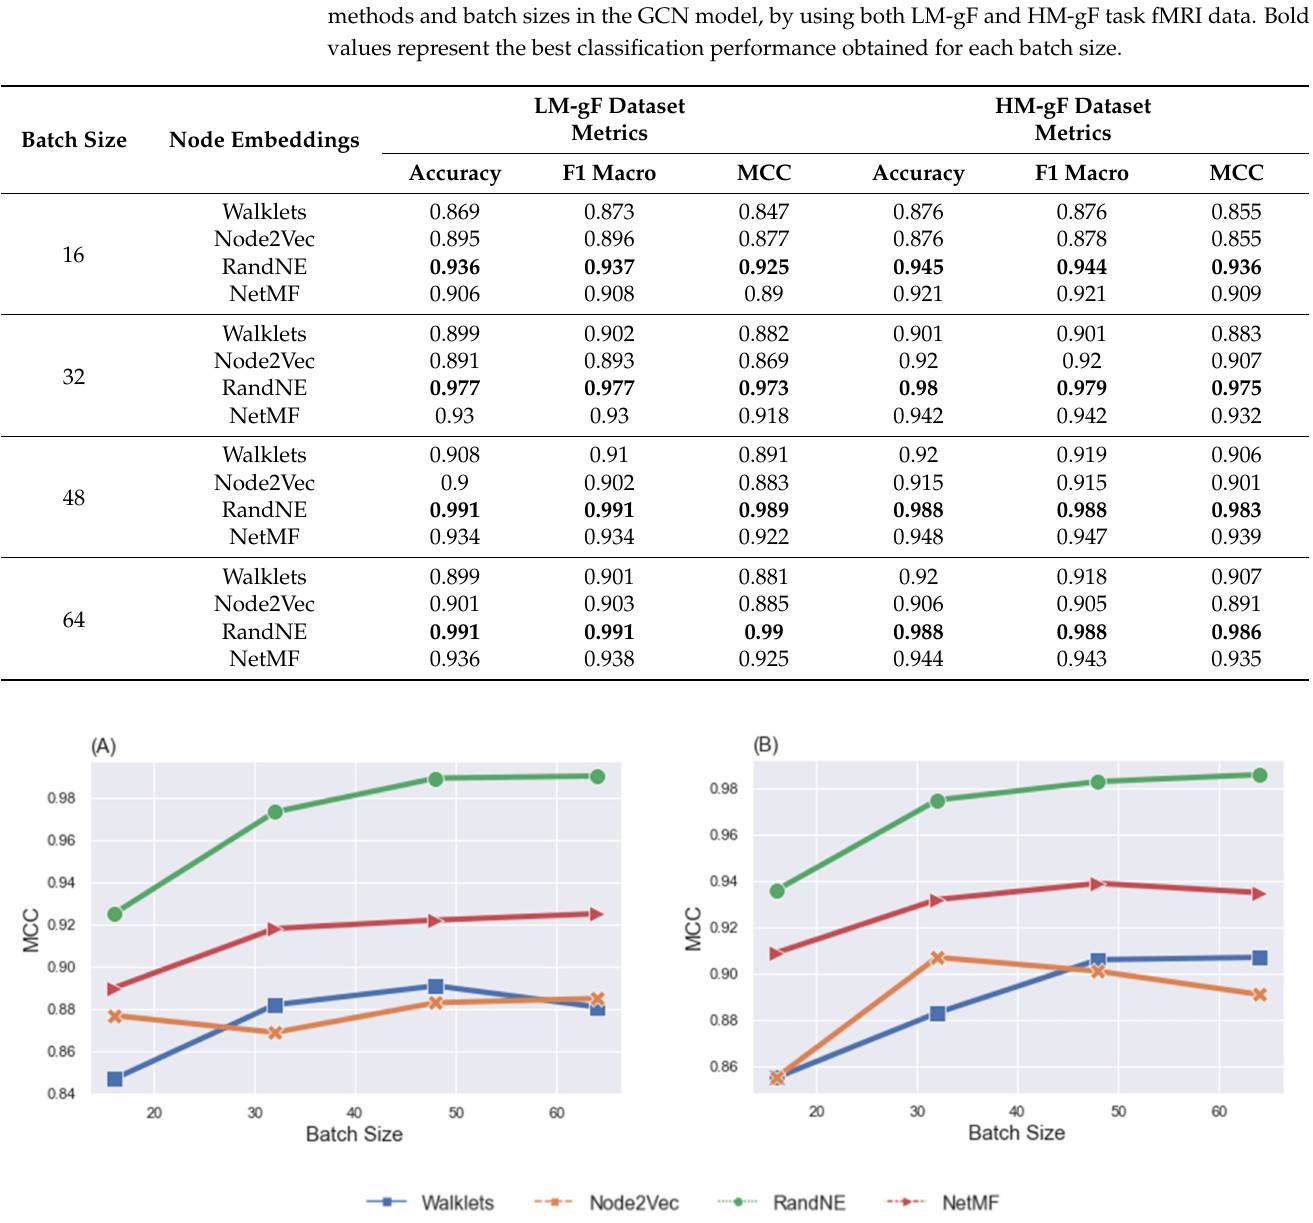
Figure 6. MCC comparison of the GCN model, taking into account the effects of node embedding methods and batch sizes, by using LM-gF task fMRI data ( A ) and HM-gF task fMRI data ( B ). Statistical analysis concerning MCC. To assess the influence of individuals’ gF-scores on the classification performance, we conducted the same procedure as the previous scenario for gender differences. However, we found that the GCN model had the best classification performance when RandNE was used as the node embedding method. Simi- larly, the model was set up and trained with a batch size of 48 and a learning rate of 0.001 for 100 epochs to classify task fMRI data by using LM-gF and HM-gF. We obtained two groups of values indicating the accuracy performance (i.e., MCC) of the classification model in different sub-datasets (Figure 5B). The Shapiro–Wilk normality test was performed to assess normality, and a t -test was used to assess the statistical significance of the differences in classification performance. The difference was found to be non-significant ( p = 0.604), at p < 0.05. Therefore, the accuracy performance of classification task fMRI data for